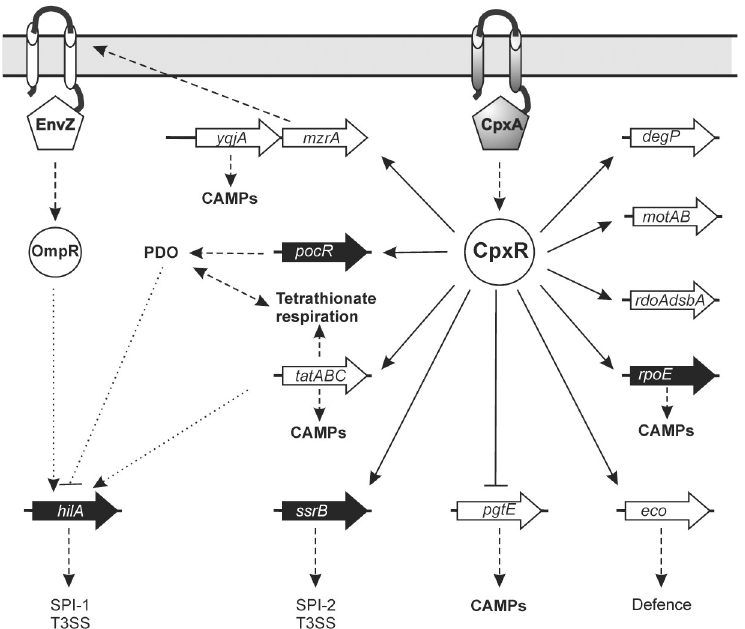
Fig 9. Model of the Cpx envelope stress network in S . Typhimurium. Genes are pictured within big arrows. Regulator genes are depicted within black arrows and the enzyme or transporters are depicted within white arrows. Thin arrows indicate a positive effect. Line with blunt ends note a negative effect. Solid lines represent direct transcriptional regulation. Regulation that is not known to be direct or indirect is represented by short-dashed lines. Long-dashed lines indicate post-translational effects. For clarity, the genes encoding HilD, HilC and RtsA are not shown. Abbreviations used are CAMPs, cationic antimicrobial peptides; PDO, 1,2-propaendiol; T3SS, type three secretion system. See text for details and